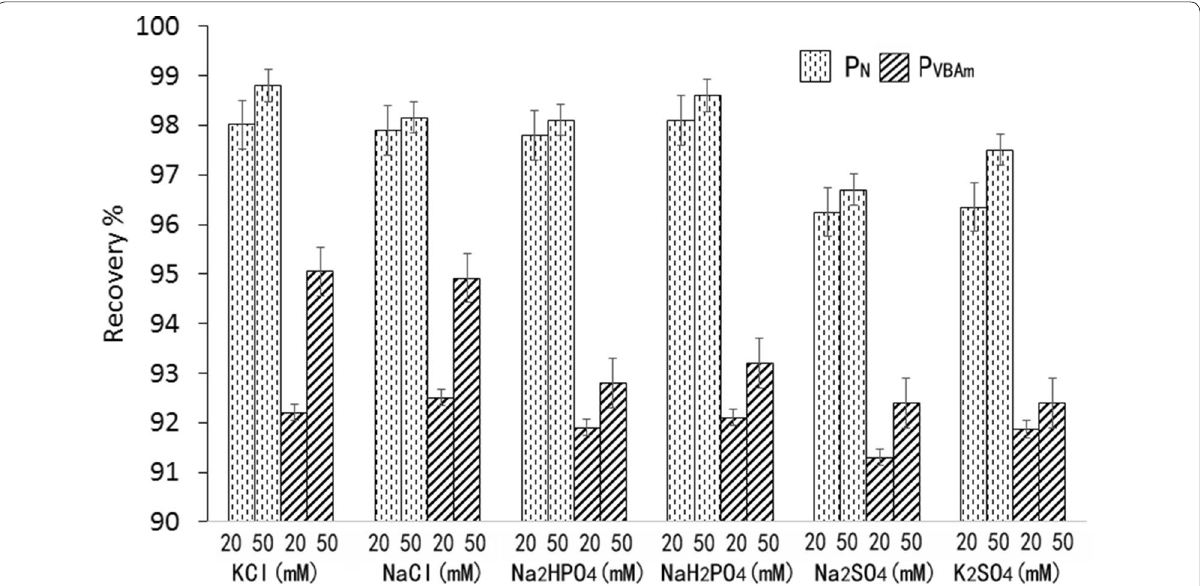
Fig. 6 Effect of different inorganic salts and concentration (20 and 50 mM) on the recovery of the two thermo-responsive polymers at pH 10. The recoveries were carried out at 38 °C for P N and 46 °C for P